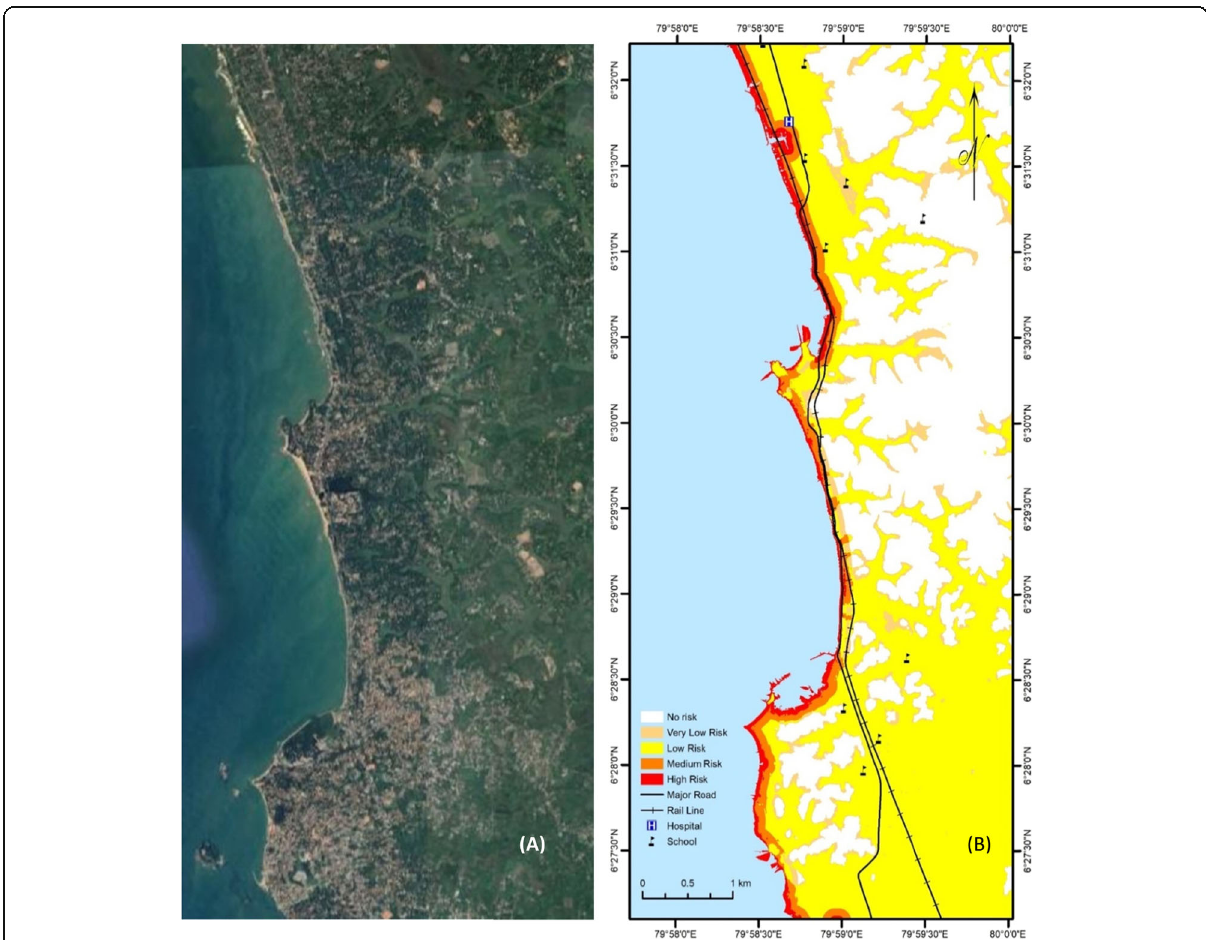
Fig. 5 ( a ) Satellite image of Beruwala, and ( b ) risk assessment map of the